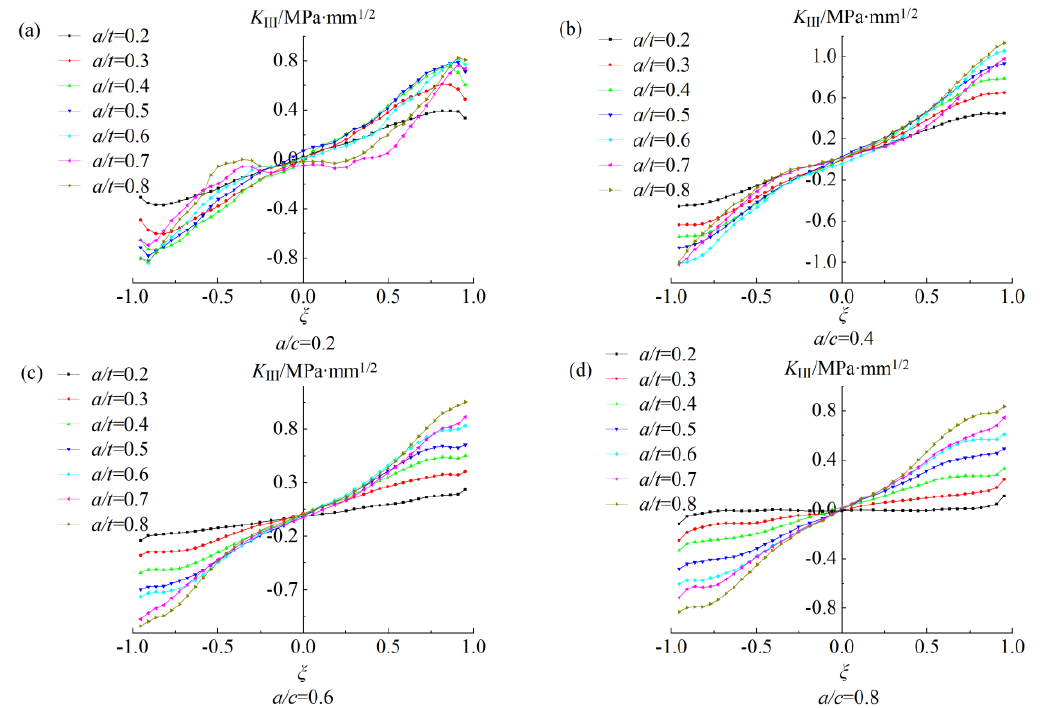
Figure 8. Distribution of type III SIF ( K III ) at the front of the semi-elliptical crack on the neck of the ampoule bottle. ( a ) a / c = 0.2. ( b ) a / c = 0.4. ( c ) a / c = 0.6. ( d ) a / c = 0.8.